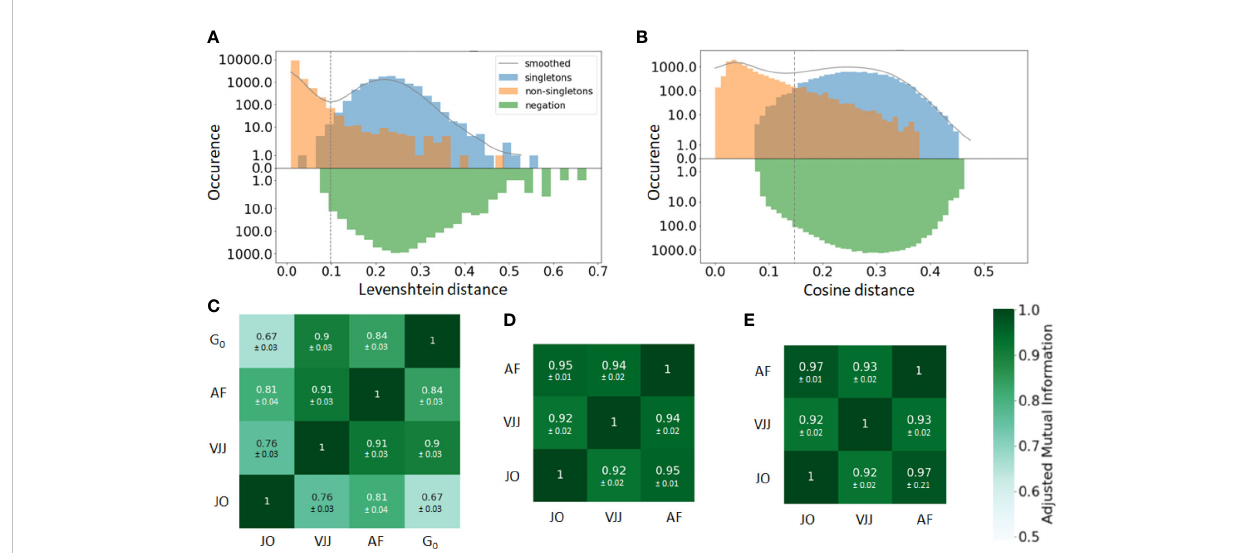
FIGURE 2 (A, B) Distance to the nearest neighbor sequence distribution, both within the same repertoire (blue and orange) and to the negation sequences (green). The distances to nearest neighbors are labeled according to the ground truth (singleton or non-singletons), i.e. the clonal groups in the simulated data. Results are shown for both the (A) alignment-based method, i.e. based on common V-J segments and junction similarity, and (B) alignment-free method, based on the cosine distance between k -mers frequency vectors of each BCR (in the plot, k =7). The choice between alignment-based and alignment-free methods results in clearly different distributions of pairwise distances. The distance threshold used to de fi ne separate clusters is displayed for each clonal identi fi cation method (dashed vertical line). (C – E) Adjusted mutual information comparing the clustering partitions obtained from the three methods: Junction-only (JO), VJ & Junction (VJJ), Alignment-free (AF) and Ground-truth ( G 0 ). Results are averaged over all samples and provided for the (C) simulated, (D) germinal center, and (E) hepatitis B dataset. Each cell shows the average adjusted mutual information and the standard deviation. The ground truth of clonal assignment is only available for the simulated dataset (Subplot